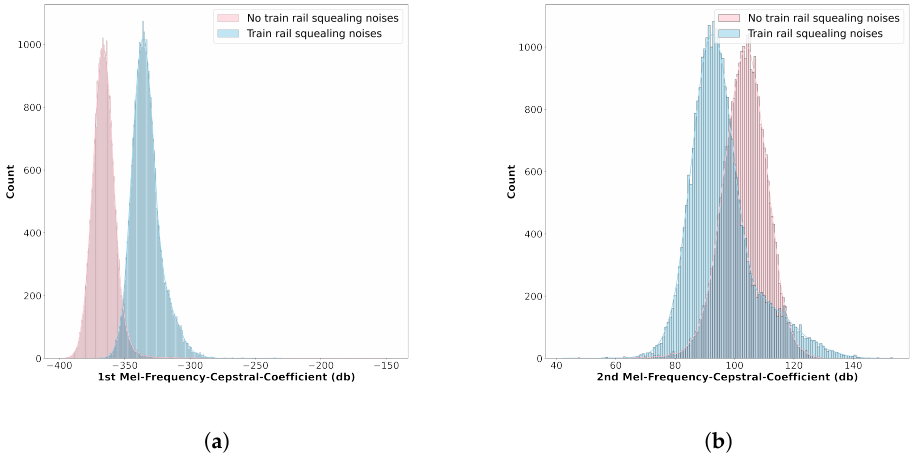
Figure 7. Comparison of the changes in distribution of the ( a ) first and ( b ) second mel frequency cepstral coefficient with and without the presence of train rail squealing